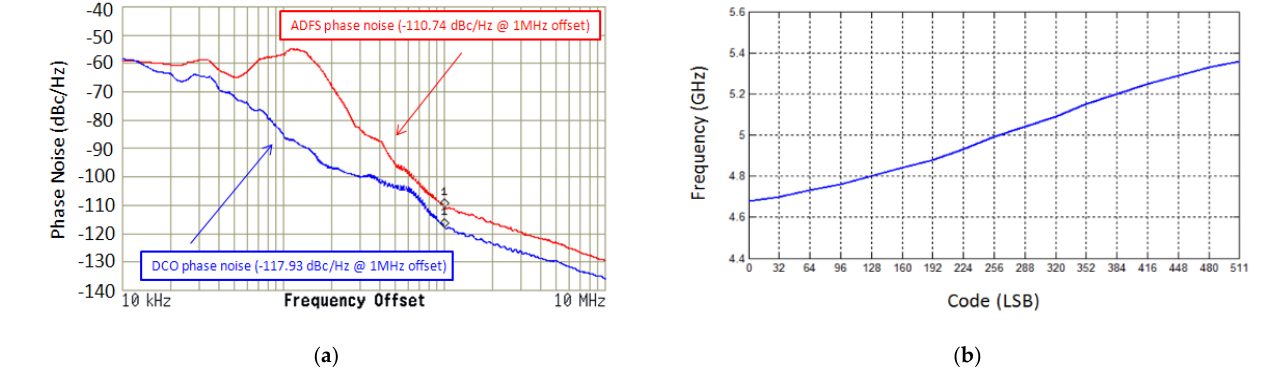
Figure 10. The proposed ( a ) DCO free running and synthesizer locking phase noises; and ( b ) tuning range measurement versus varying controlled − voltage.